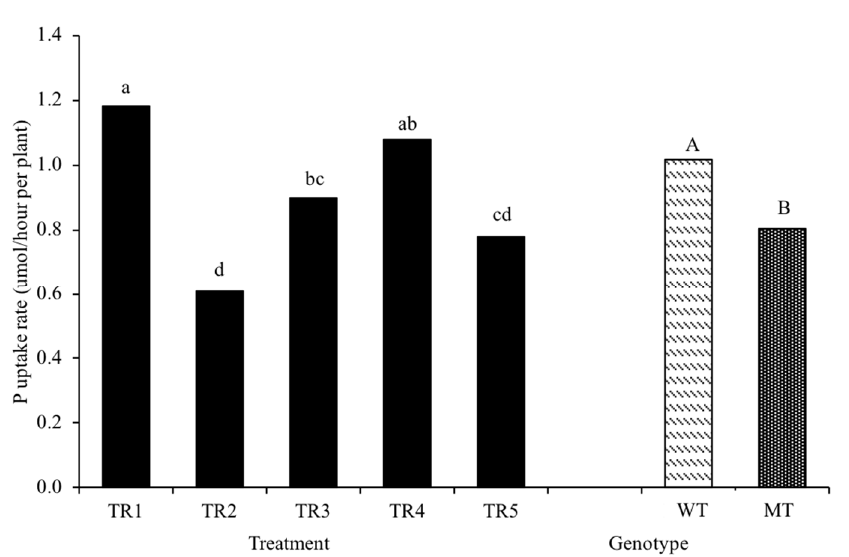
Figure 5. Phosphorus uptake rate of two barley genotypes in nutrient solutions with different P levels in a split-root system. The P treatments were: TR1 = TCP/CNS-P, TR2 = H 2 O/CNS, TR3 = H 2 O/CNS-P, TR4 = H 2 O/CNS-P + TCP, TR5 = CNS/CNS. The solution was sampled once every two hours for eight hours to determine the remaining P concentration (N = 4). Different lower-case letters indicate significant differences ( p ≤ 0.05) among treatments and different upper-case letters indicate significant difference ( p ≤ 0.05) between the genotypes according to a Tukey’s HSD test. WT stands for wild type, and MT for the root hairless brb mutant.